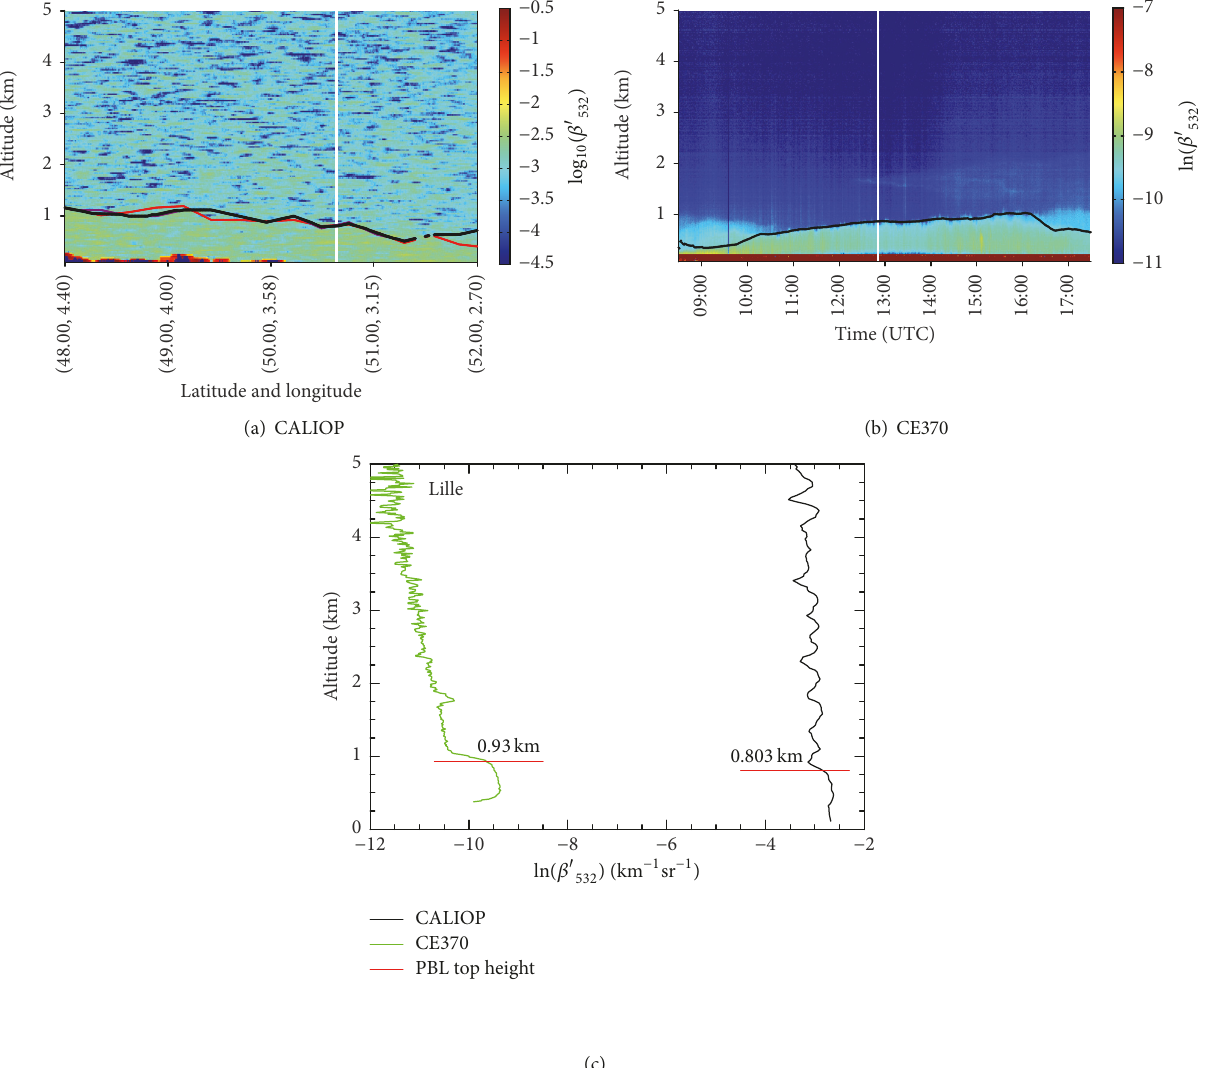
Figure6:Verticalprofilesoftotalattenuatedbackscatterat532 nmunderclearskyconditions,inwhich(a)isforCALIOPand(b)isforCE370. In (a), the PBLH results derived by wavelet method (red line), improved maximum variance method (purple line), and integrated algorithm (black bold line) are, respectively, shown in the same figure along with latitude and longitude; (b) is similar to Figure 3(b), but for another day. The PBLH results (black points) were derived from CE370 during daytime. The vertical white solid lines in (a) and (b) indicate the points of the nearest spatial and temporal coincidence between CALIOP footprints and CE370 Lidar site, and (c) shows the comparison of vertical profiles of backscatter signals and PBL top height results between CALIOP and ground-based Lidar. The vertical profiles are corresponding to the vertical white solid lines in (a) and